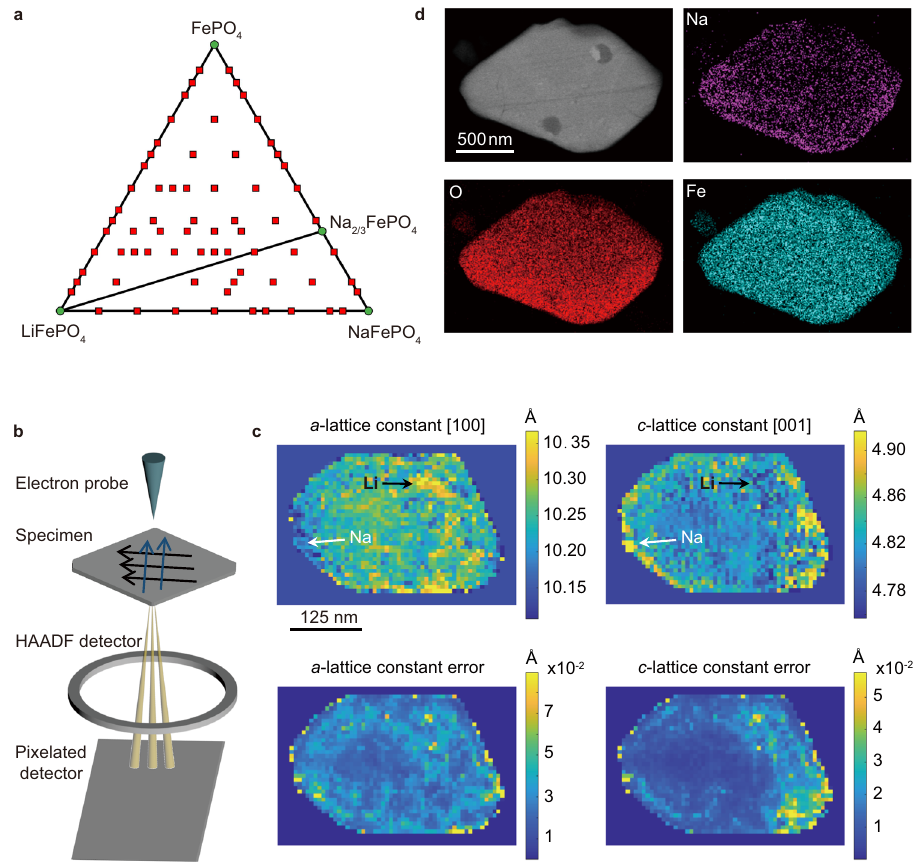
Fig. 1 | Li and Na phase separation in FePO 4 host. a Ternary phase diagram of FePO 4 -LiFePO 4 -NaFePO 4 . The stable phases (green dots) are FePO 4 , LiFePO 4 , Na 2/3 FePO 4 , and NaFePO 4 . The red squares denote the calculated intermediate compositions in the Li x Na y FePO 4 (0 ≤ x+y ≤ 1) system. b Schematic illustrating the setup of scanning electron nanodiffraction. The blue and black arrows denote the